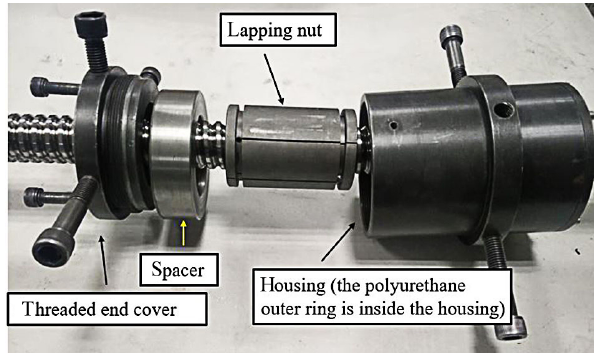
Figure 5. Installation method of the lapping